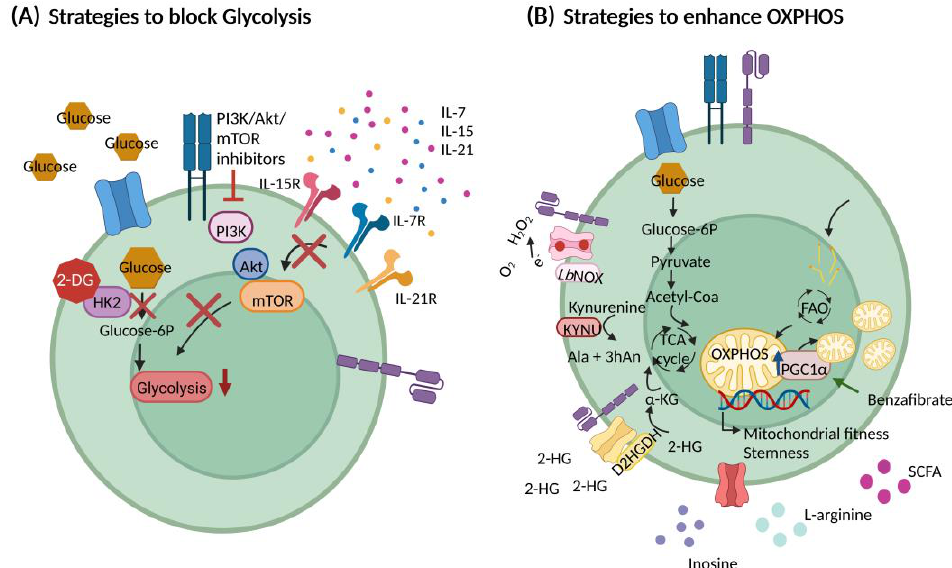
Figure 5. Strategies to modulate CAR T cell metabolism. ( A ) Strategies to block glycolysis. Cell cul- turing conditions can be improved by optimizing the use serum-containing and/or serum-free media. Treatment with cytokines such as IL-7, IL-15 or IL-21 led to the generation of the preferred T cell phenotype. Metabolic skewing (towards FAO and OXPHOS) can also be achieved by interfering with glycolysis by interfering with glycolytic enzymes such as hexokinase 2 (HK2) or glycolytic signaling such as the PI3K/Akt/mTOR axis. ( B ) Strategies to enhances oxidative phosphorylation (OXPHOS). Genetic engineering can be utilized for driving mitochondrial biogenesis and fitness (by, e.g., PGC1 α ) or metabolizing/redirect substrates such as 2-HG (by, e.g., D2HGDH), kynurenine (by, e.g., kynureni- nase) or O 2 (by, e.g., LbNOX ). Supplementation of nutrients such as inosine, L-arginine or short chain fatty acids (SCFAs) could also have a beneficial effect for CAR T cell metabolism and stemness. Abbre- viations: Phosphoinositide 3-kinase (PI3K), protein kinase B (Akt), mammalian target of rapamycin (mTOR), interleukin (IL), interleukin receptor (IL-R), fatty acid oxidation (FAO), oxidative phospho- rylation (OXPHOS), Peroxisome proliferator-activated receptor-gamma coactivator alpha (PGC1 α ), short chain fatty acids (SCFA), 2-Deoxy-D-glucose (2-DG), hexokinase 2 (HK2),